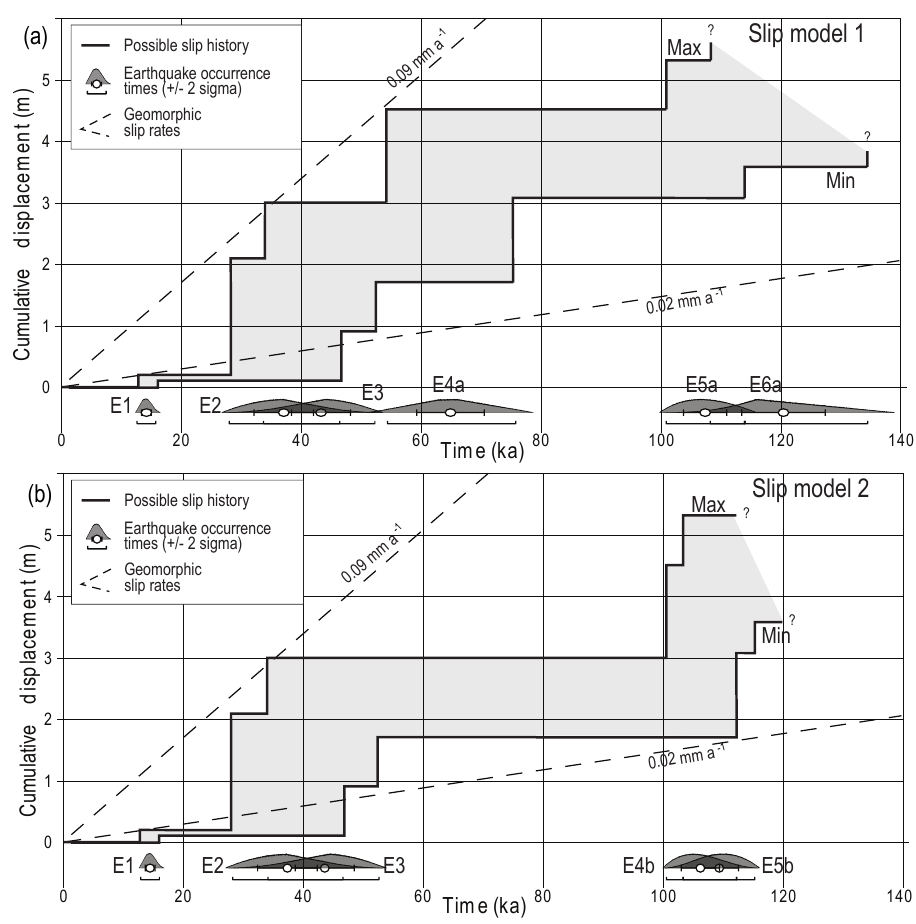
Figure 13. Comparison of surface slip rates for the Markgrafneusiedl Fault (MF) from geomorphic constraints and from trench results. On the left the constraints for slip model 1 are plotted; on the right, those for slip model 2 are shown.